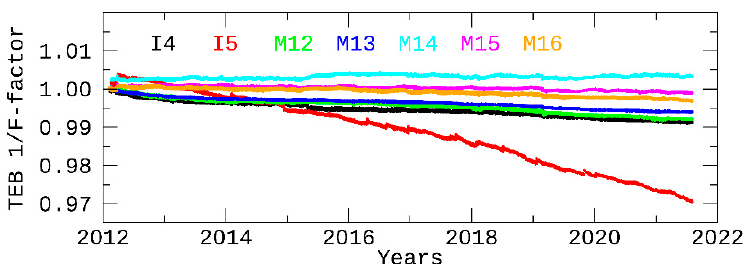
Figure 6. S-NPP VIIRS TEB band-averaged gains (1/F-factor) during nominal operations over the entire mission. Values are normalized to 20 January 2012. Only HAM-side A is illustrated.